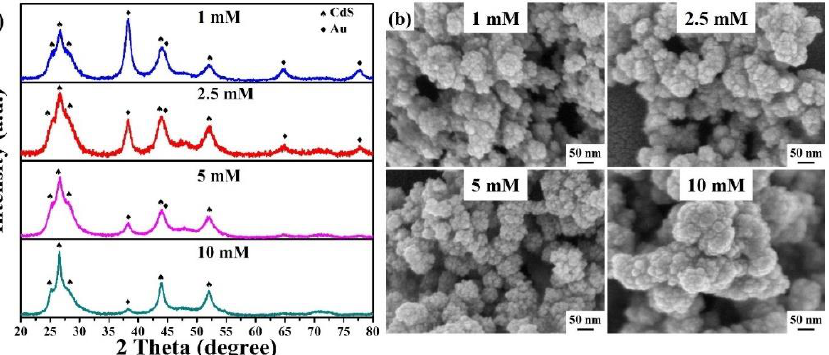
Figure 2. ( a ) XRD spectra and ( b ) FESEM images of Au@CdS nanocomposites were grown at different CdS precursor concentrations. The CdS precursor concentrations were 1, 2.5, 5, and 10 mM, respectively.